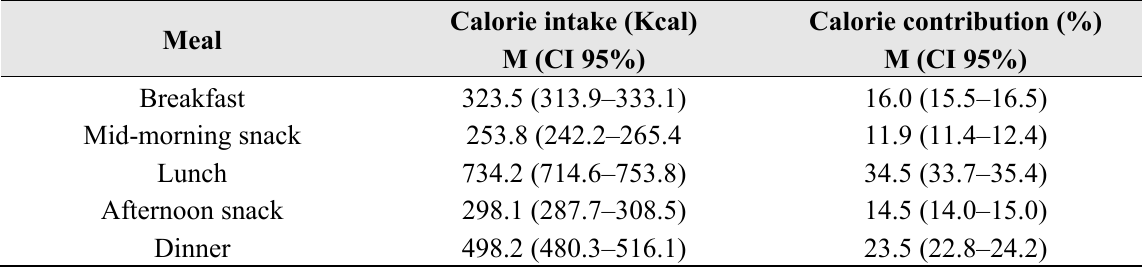
Table 1. Calorie intake (kilocalories) and calorie percentage contribution (%) of daily meals in the surveyed students.